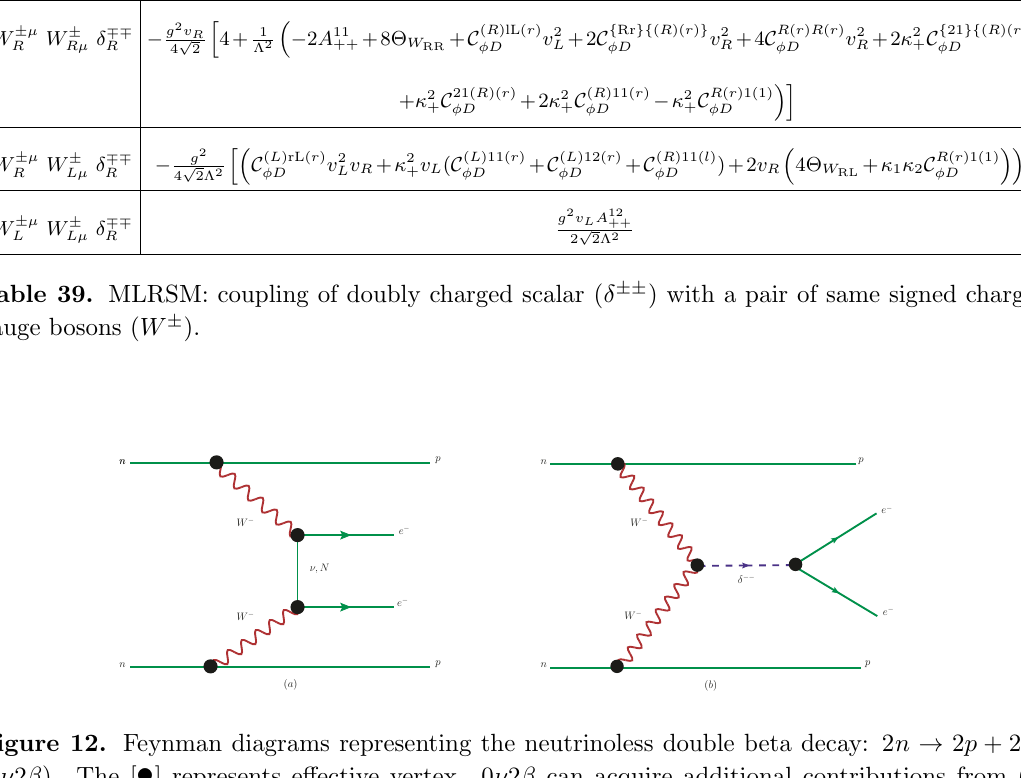
l (cid:6) l (cid:7) l (cid:7) . The [ ] represents e(cid:11)ective vertex. m i ! j k (cid:15)